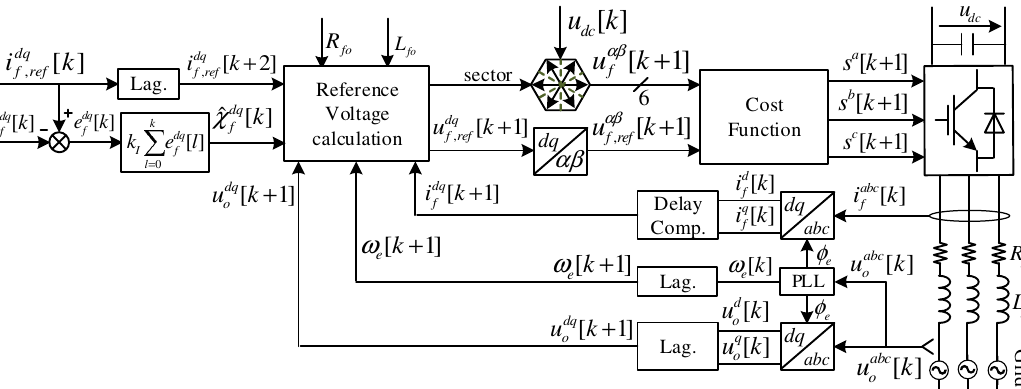
Figure 4. Block-diagram of the proposed DMPC for power converters tied to the electric